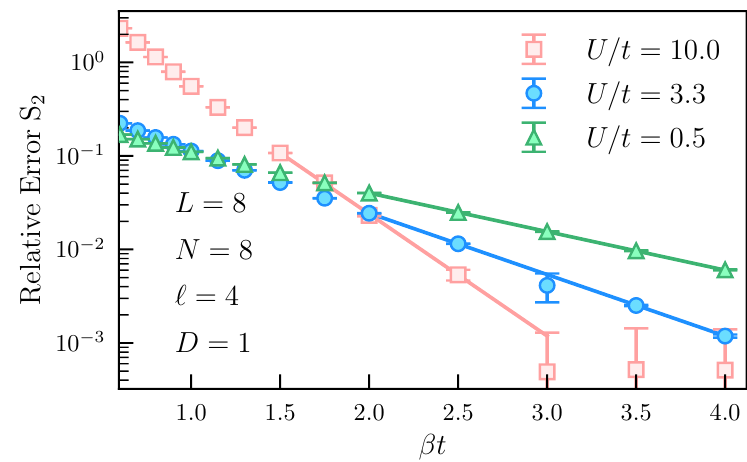
Figure 9: β -scaling of relative error of full entanglement S sites at unit-filling. The system is bipartitioned into equally sized subregions A , B of size ℓ = 4 sites. The relative error of S are simple exponential